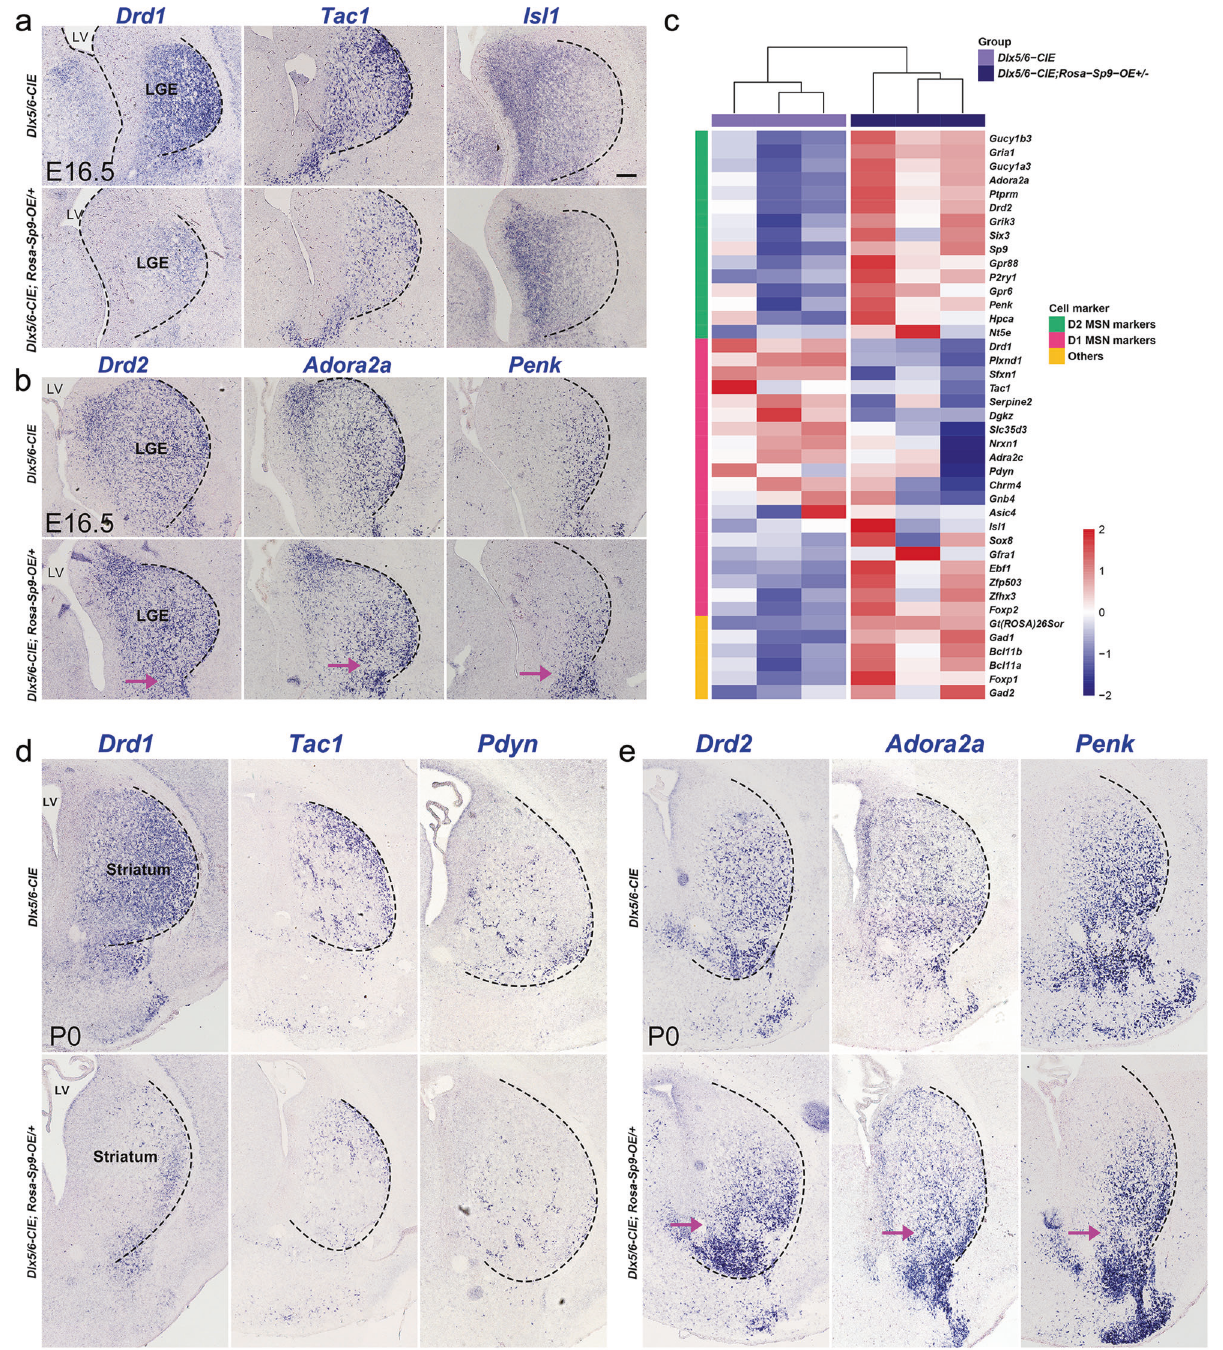
Fig. 6 Sp9 overexpression represses the identity of D1-MSNs and promote the identity of D2-MSNs. a In situ hybridization staining showed a signi fi cant reduction in Drd1 and Tac1 , markers of D1-MSNs in the Dlx5/6-CIE; Rosa-Sp9-OE/ + striatum, while the expression of Isl1 was mostly unaffected in the Dlx5/6-CIE; Rosa-Sp9-OE/ + striatum at E16.5. b In situ hybridization staining showed an increase in Drd2 , Adora2a and Penk , markers of D2-MSNs in the Dlx5/6-CIE; Rosa-Sp9-OE/ + striatum at E16.5. c Heatmap showing the expression levels of striatum- enriched genes (D1-MSNs enriched genes, D2-MSNs enriched genes and MSN-enriched genes) in E16.5 Dlx5/6-CIE; Rosa-Sp9-OE/ + and Dlx5/6- CIE striatum (obtained from bulk RNA sequencing). d In situ hybridization showing that the expression of D1-MSN-enriched genes ( Drd1 , Tac1 and Pdyn ) were downregulated in P0 Dlx5/6-CIE; Rosa-Sp9-OE/ + striatum. e In situ hybridization staining showed that D2-MSNs enriched genes ( Drd2, Adora2a and Penk ) were upregulated in P0 Dlx5/6-CIE; Rosa-Sp9-OE/ + striatum. Magenta arrows indicate a signi fi cant up-regulation expression of Drd2, Adora2a and Penk in the ventral part of the striatum. Scale, 100 µm in a for a , b and d , e . Abundant cell types are generated from radial glial cells directly DISCUSSION or indirectly through transit-amplifying progenitors in the The correct speci fi cation and differentiation of striatal projection subpallium. The heterogeneity of subpallial progenitors has been neurons are important for normal brain function, and defects in established, but further study is needed. Our scRNA-seq data these processes underlie motor and cognitive impairment. Cell Death Discovery (2022)